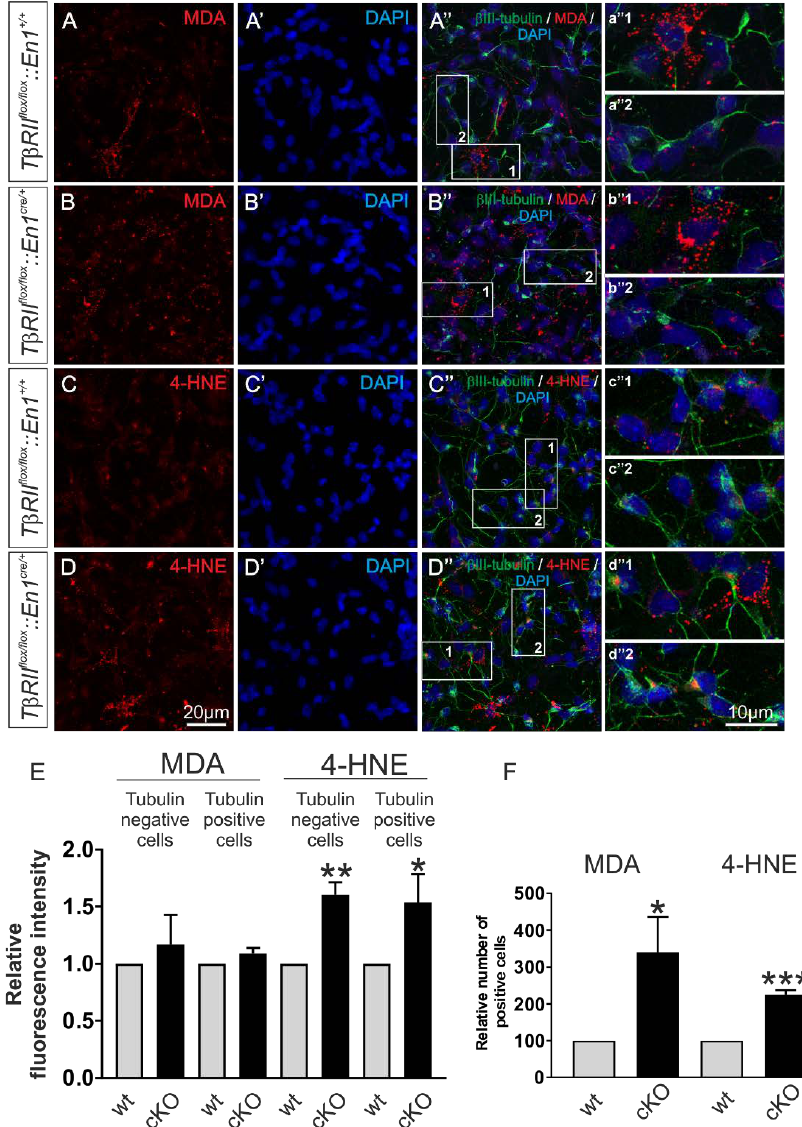
Figure 7. Conditional deletion of TGF- β signaling from Engrailed 1-derived β -III tubulin positive and β -III tubulin negative cells impairs mitochondrial function. ( A – D ) Immunofluorescence and subsequent confocal microscopy of the lipid peroxidation markers malondialdehyde (MDA) ( A , B ) and 4-hydroxynonenal (4-HNE) ( C , D ) in primary ventral midbrain / hindbrain neuronal cultures from